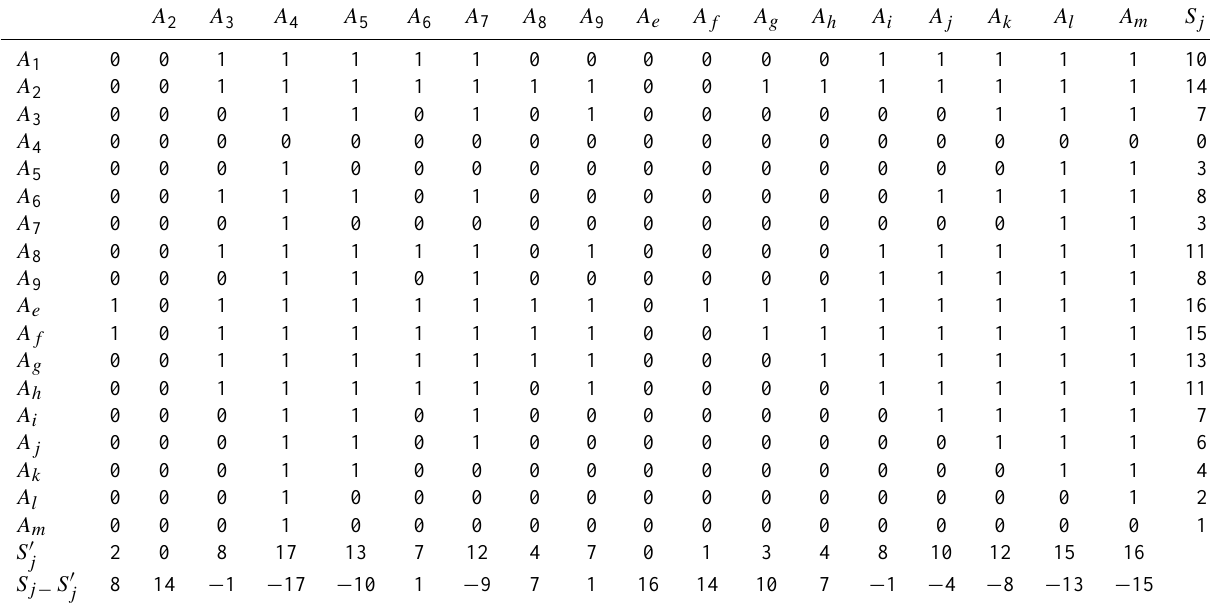
Table 8. N × N matrix used in the Borda and Copeland